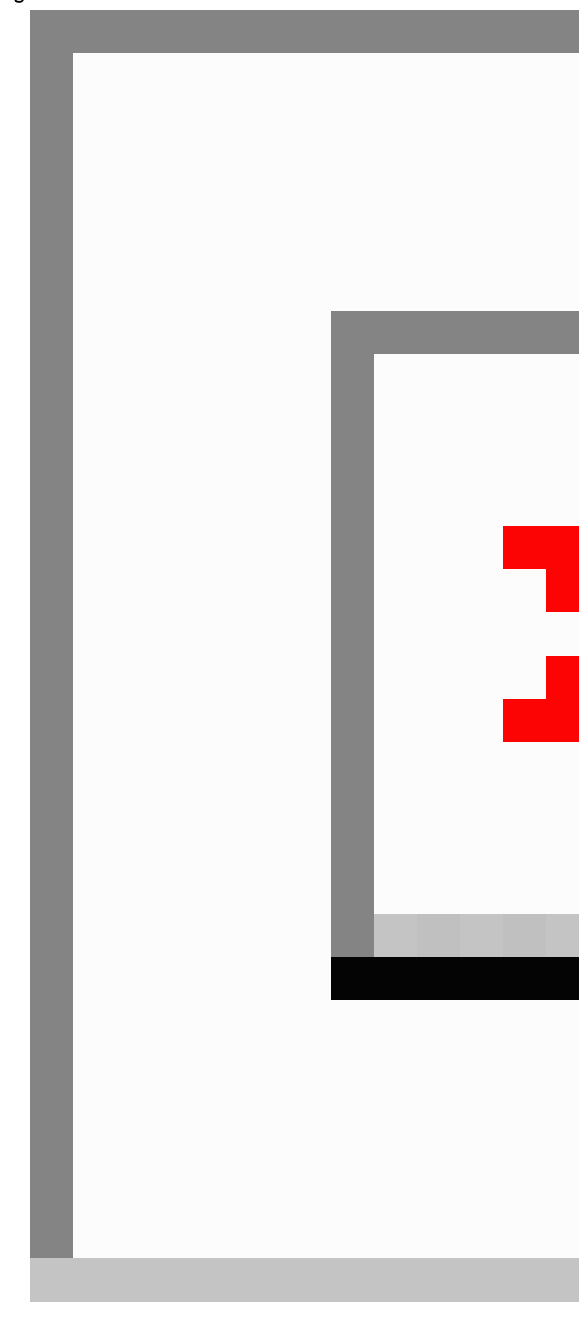
Figure 2. Visualization of the correlation matrix in